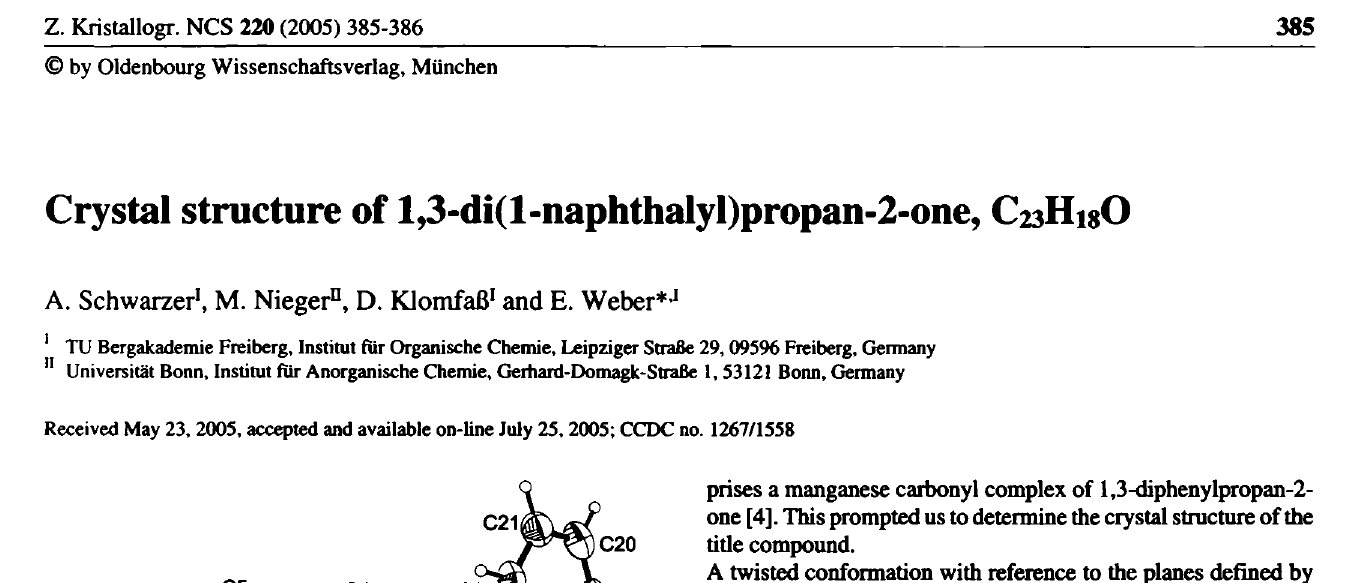
Table 1. Data collection and handling.